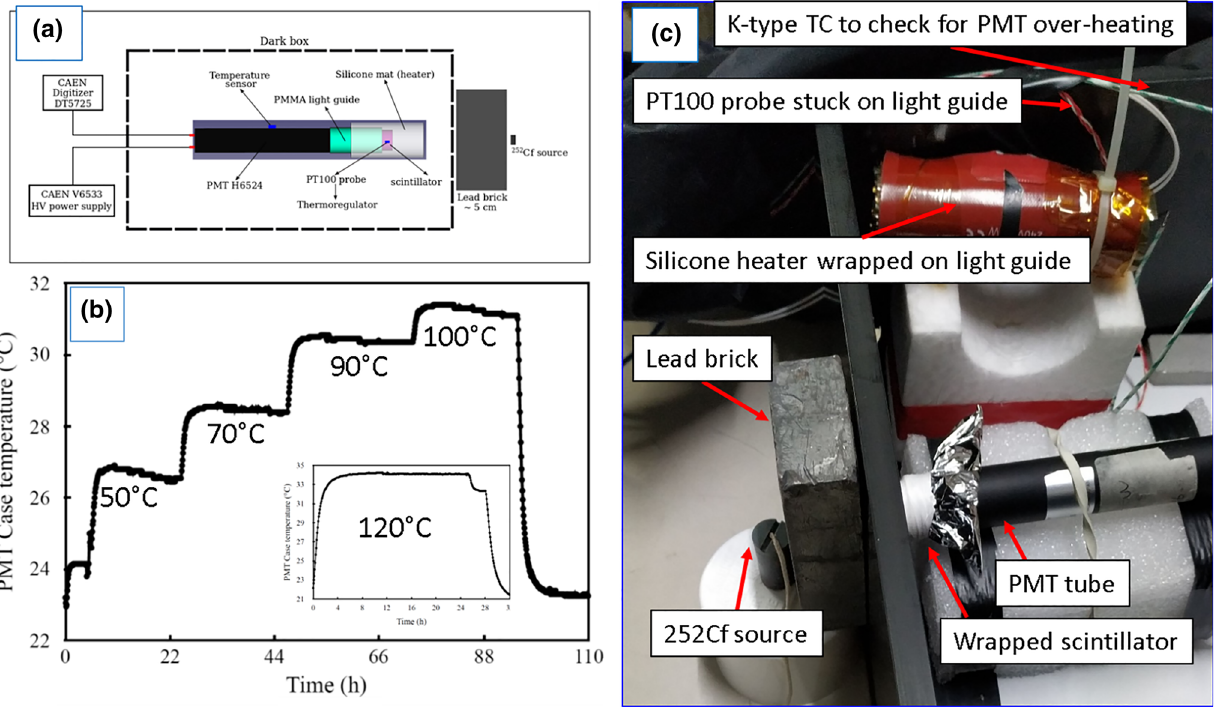
Fig. 1 a Scheme of the set-up used to measure the light output with calibrated sources and the n/ γ bi-dimensional plot of the scintillators at different heating temperatures; b temperature recorded on PMT side